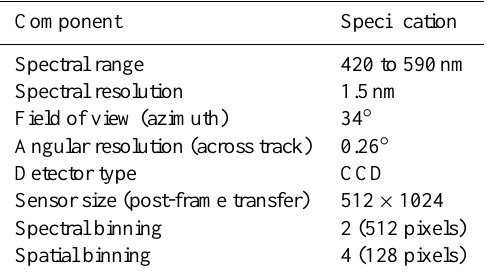
Table 1. Relevant specifications of the CompAQS spectrometer used in the ANDI